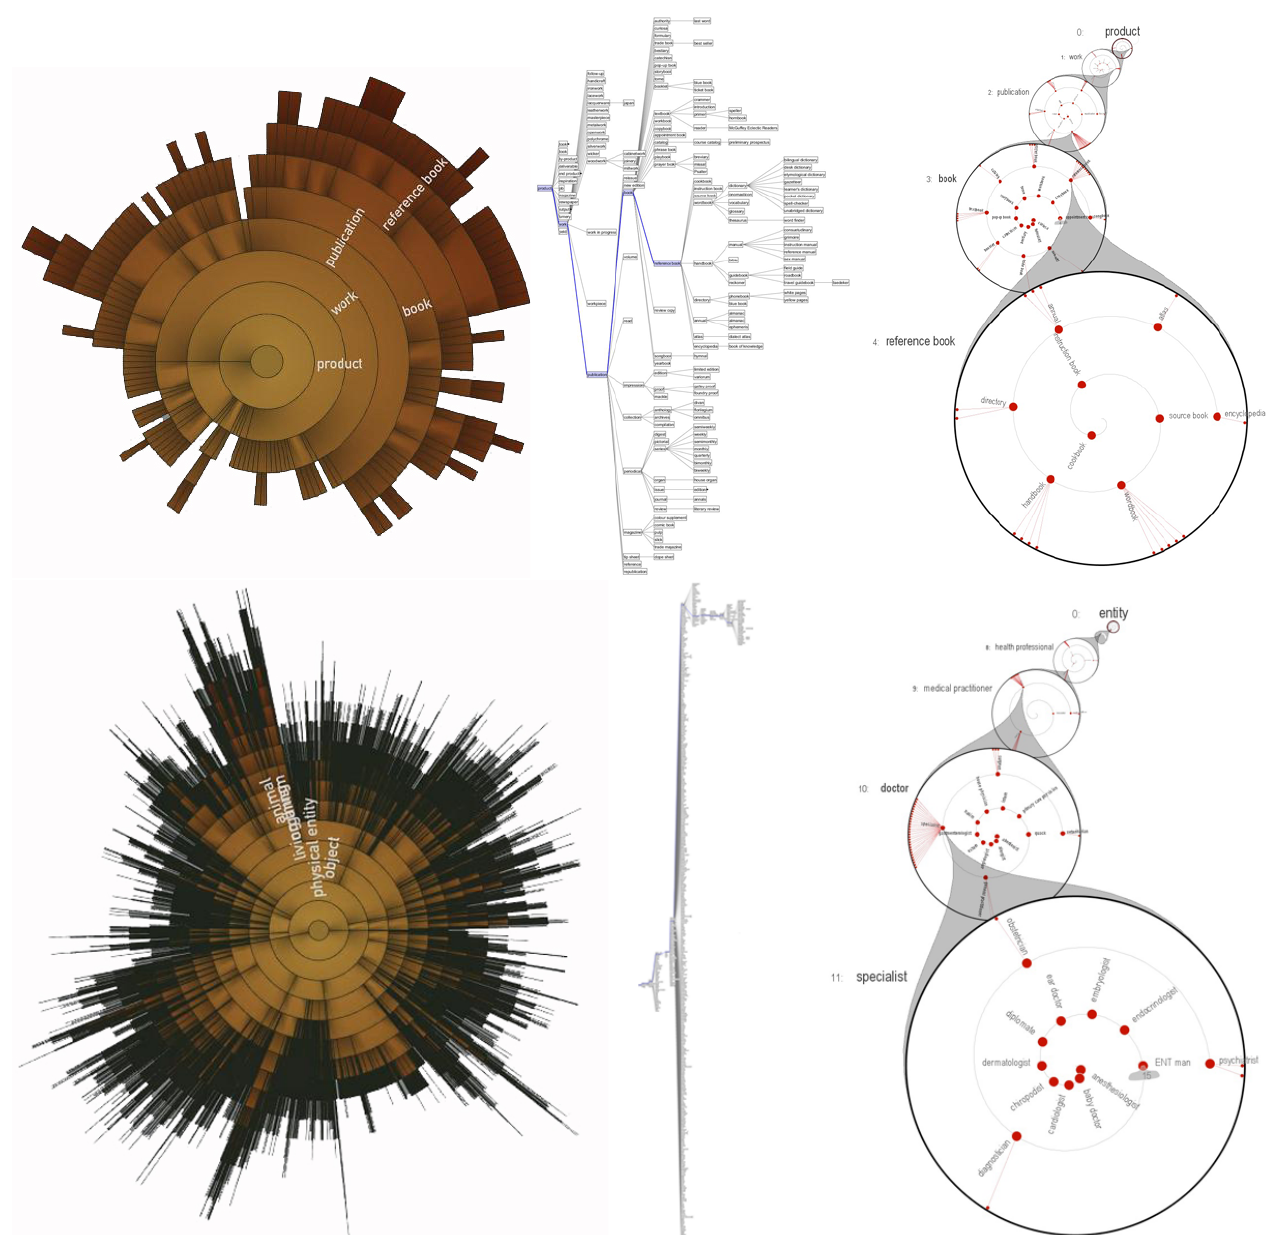
Figure 14. Comparison of three tree visualization techniques for a small tree (top: 197 nodes, navigated to level 4) and a large tree (botton: 75,000 nodes, navigated to level 11). Left: Sunburst/Lark [15, 33]. Middle: SpaceTree [17]. Right: